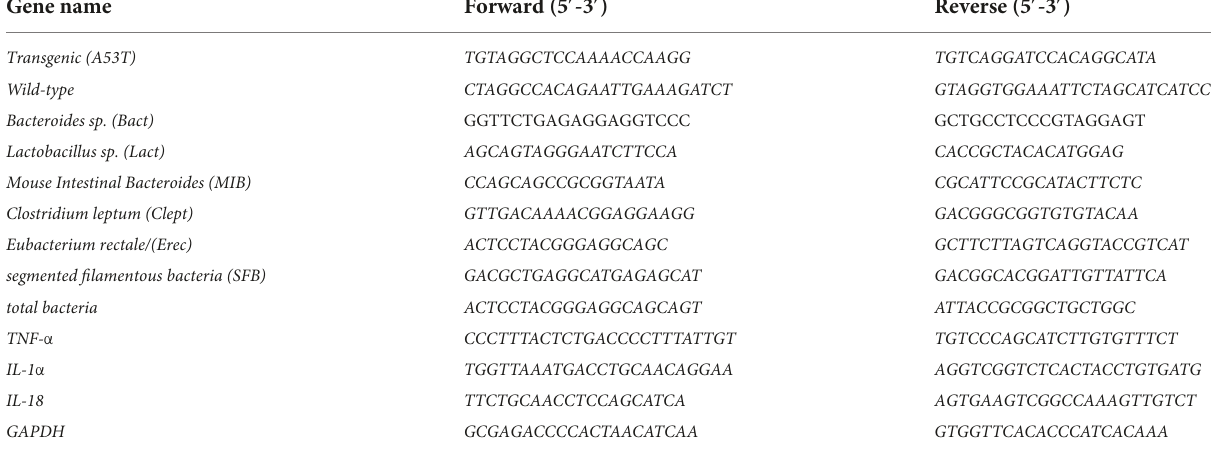
TABLE 1 List of primer